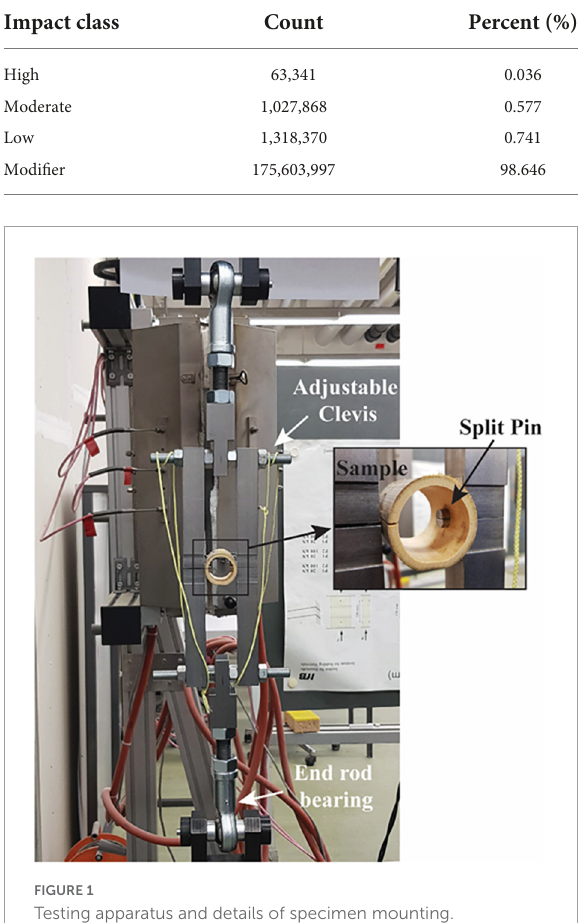
FIGURE1 Testing apparatus and details of specimen